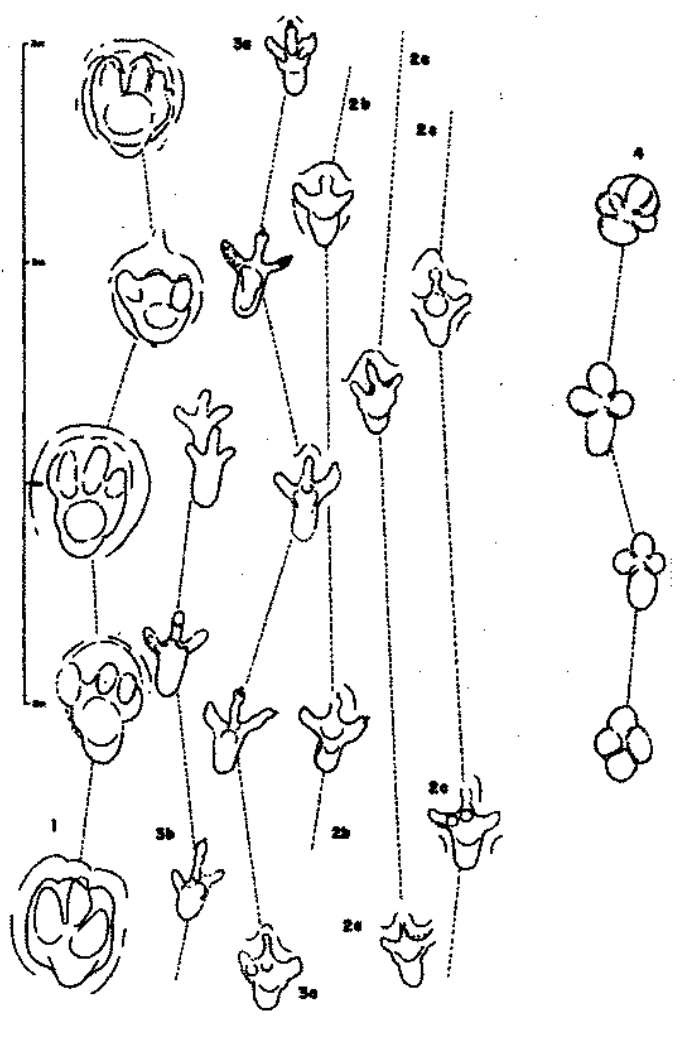
Fig. 20 – Trackways from the locality Passagem das Pedras, Sousa, Paraíba. Those tracks were found in the strata of the Sousa Formation: 1 - Sousaichnium pricei Leonardi 1979, attributed to Iguanodontidae; 2 and 3 - Moraesichnium barberenae Leonardi 1979, attributed to a theropod; 4 - Staurichnium diogenis Leonardi 1979, attributed to Iguan- odontidae (from Leonardi 1994). Trackways 1 and 4 are regarded as evidencesofthepresenceofOrnithischiandinosaursinBrazil(Leonardi 1979,